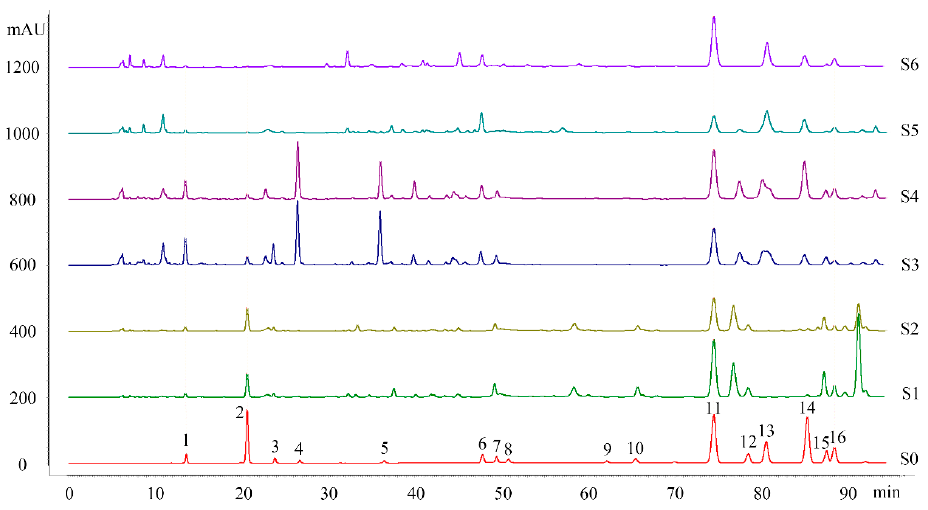
Figure 5. The HPLC chromatograms of the bud and tender leaves extracts of P. davidiana dode (S1 and S2), P. davidiana Rehd (S3 and S4), P. simonii Carr (S5 and S6) and standard solution (S0).